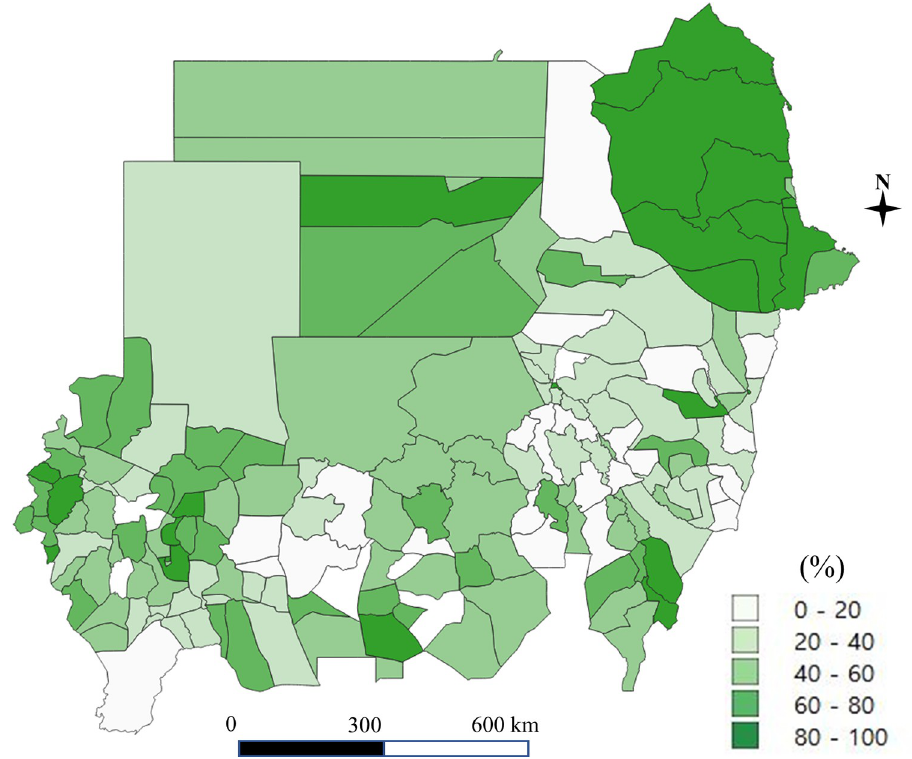
Fig 3. Improved latrine at the school level (the authors generated the